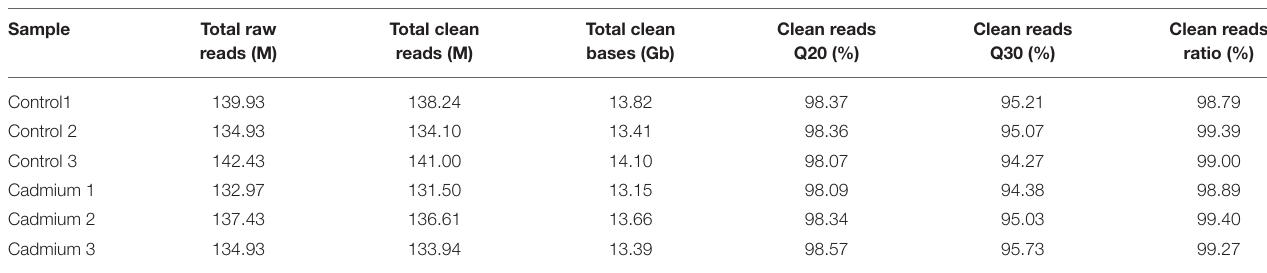
TABLE 2 | Data filtering for RNA-seq.